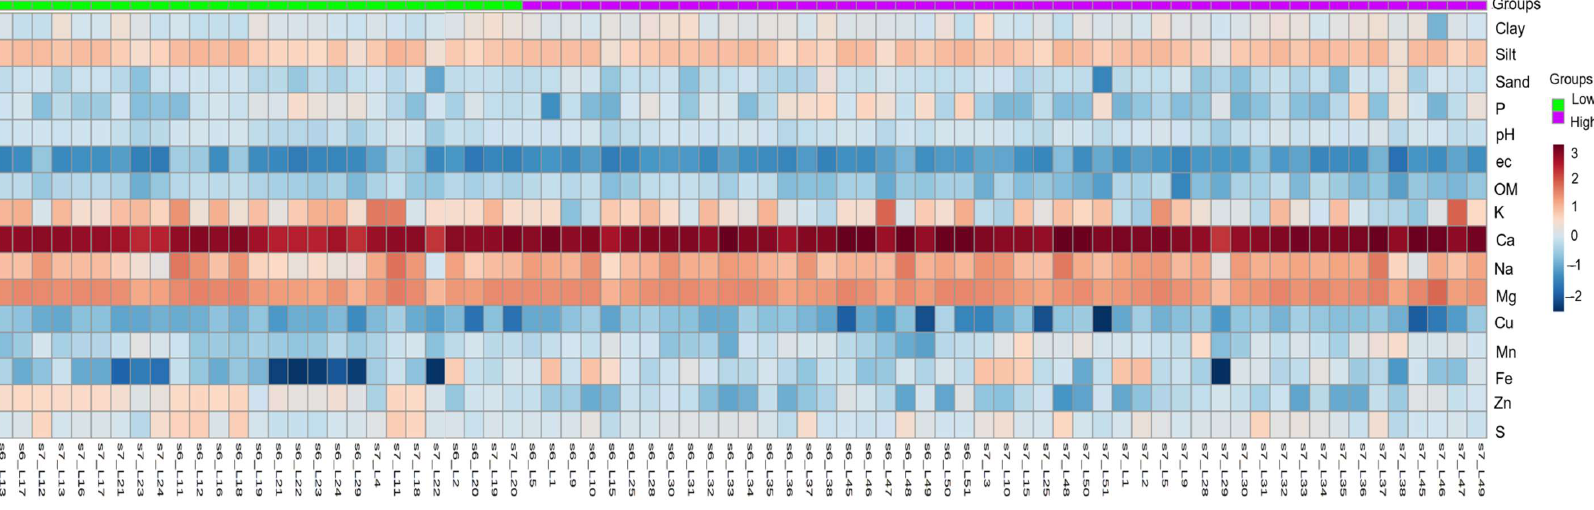
Figure 3. Heatmap generated from soil data of the banana lots with low (green) or high (purple) incidence of BW evaluated in year 2016 (s6) and year 2017 (s7), which represents increasing concentration values of the soil variables (blue to red color) for the study periods.